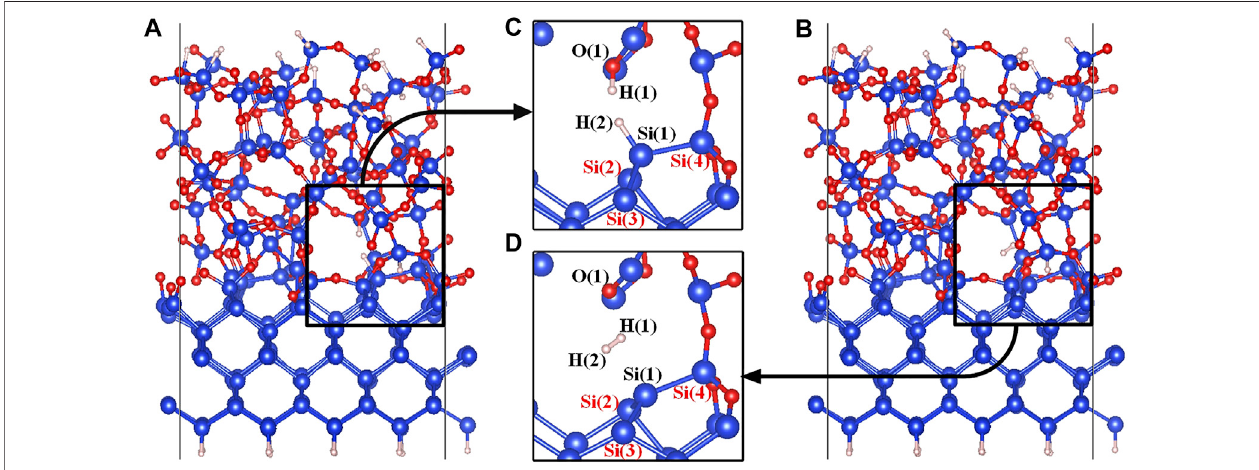
FIGURE 3 | (A) The initial state model of the a -SiO 2 /Si (100) interface, (B) The fi nal state model of the a -SiO 2 /Si (100) interface, (C) The initial state (state 00) partial fi gure of the P